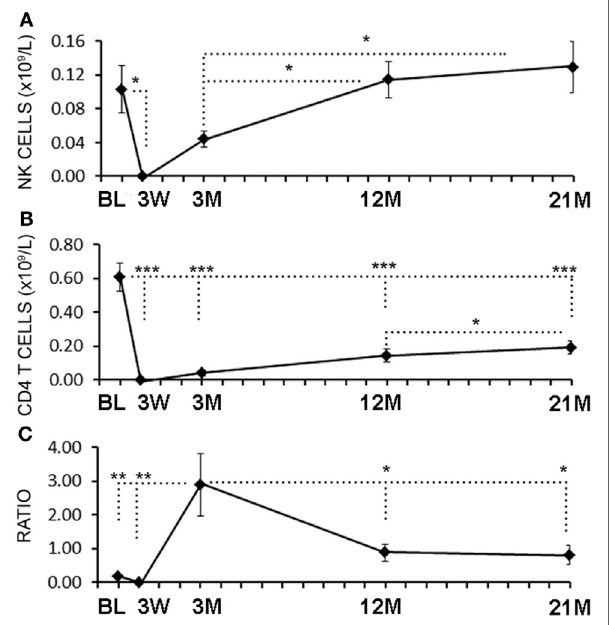
FigUre 1 | Rapid reconstitution kinetics of natural killer (NK) cell counts compared with CD4 T cells in aHSCT-treated multiple sclerosis (MS) patient blood. From freshly drawn blood samples, absolute number of NK cell counts (a) and CD4 + T cell counts (B) were determined at baseline (BL), and at 3 weeks (3 W), 3 months (3 M), 12 months (12 M), and 21 months (21 M) post-aHSCT. The ratio of NK cells to CD4 + T cells was calculated (c) . N = 7